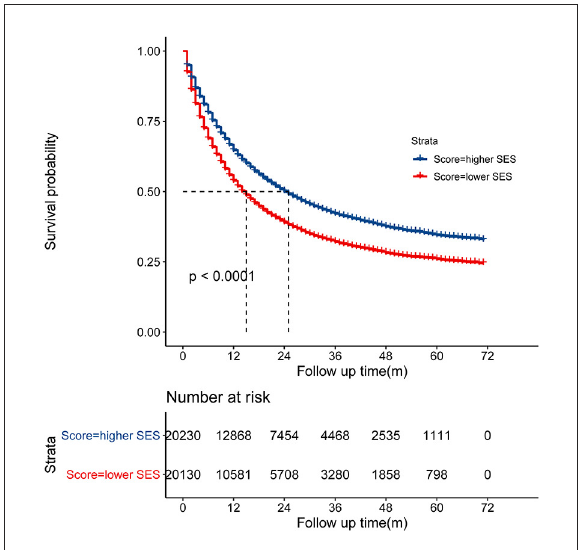
FIGURE2 Kaplan-Meier curve showed that the SES-1 stage was associated with better cancer-specific survival